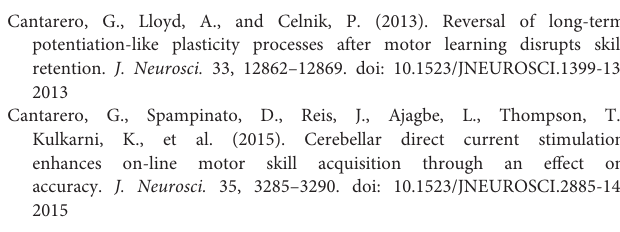
only (blue) groups. Supplementary Figure 2 | Slice-by-slice whole brain activation from Task-related activity analysis. Supplementary Figure 3 | Slice-by-slice whole brain activation from Performance specific task activity analysis. Supplementary Figure 4 | Slice-by-slice whole brain activation during practice that is associated with immediate retention performance. Supplementary Figure 5 | Spatial accuracy (maximum cross correlation) during practice and retention for (A) all participants ( N = 40) and (B) between groups (motivation plus feedback = green, feedback only = blue). IR, immediate retention; DR, delayed retention. Error bars = ± 1 standard error. Supplementary Figure 6 | Intrinsic motivation inventory subscale rating for motivation plus feedback (green) and feedback only